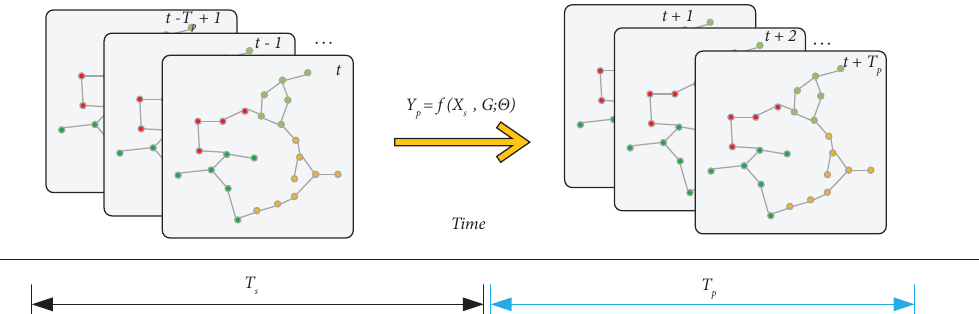
Figure 2: Te goal of trafc forecasting is to ft a non-linear function that extracts the spatial and temporal dependencies in past trafc fows, and thus, accurately predicts future trafc fows.